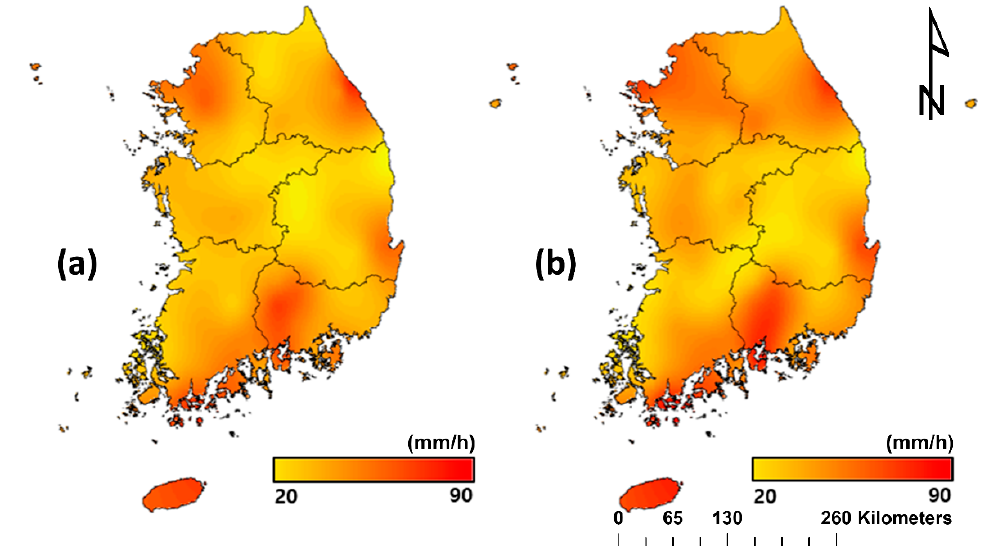
Figure 6. Design rainfall intensity for which RCP was applied (duration 3 h and return period 30 years). These figures show the spatial distribution of the design rainfall intensity estimated ( a ) from H2-MM5-RCP 4.5 (2021–2050), ( b ) from H2-MM5-RCP 8.5 (2021–2050).